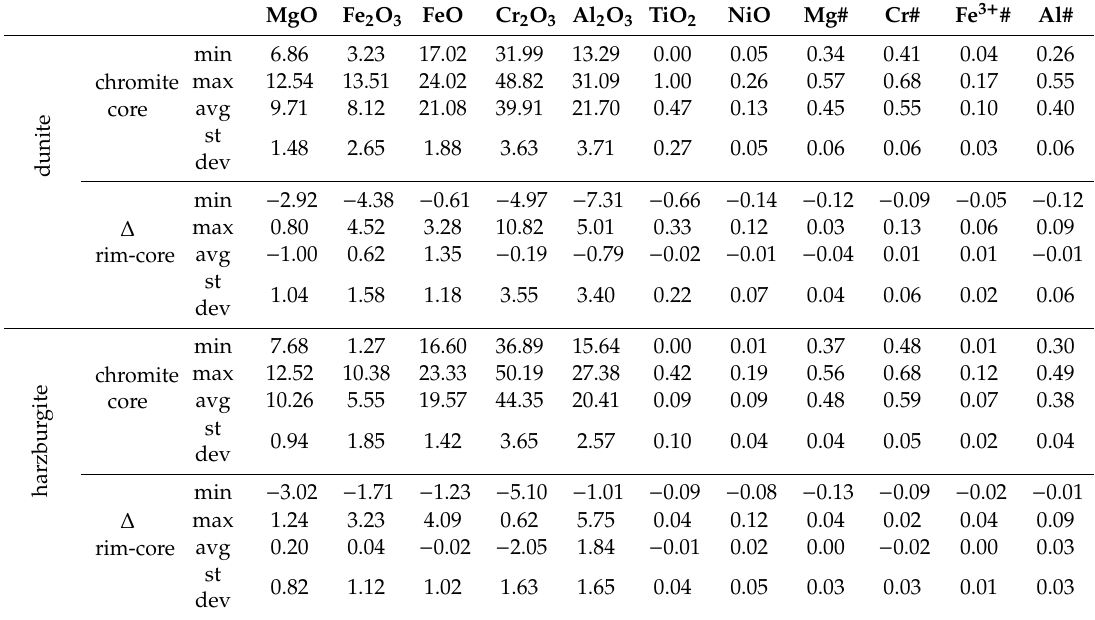
Table 1. Representative electron microprobe analyses of selected element oxides and ratio-cations number for Cr-spinel crystals from all dunite and harzburgite samples; ranging value of max, min, average, standard deviation and delta value (rim minus core) are also shown. Complete dataset is available in the supplementary